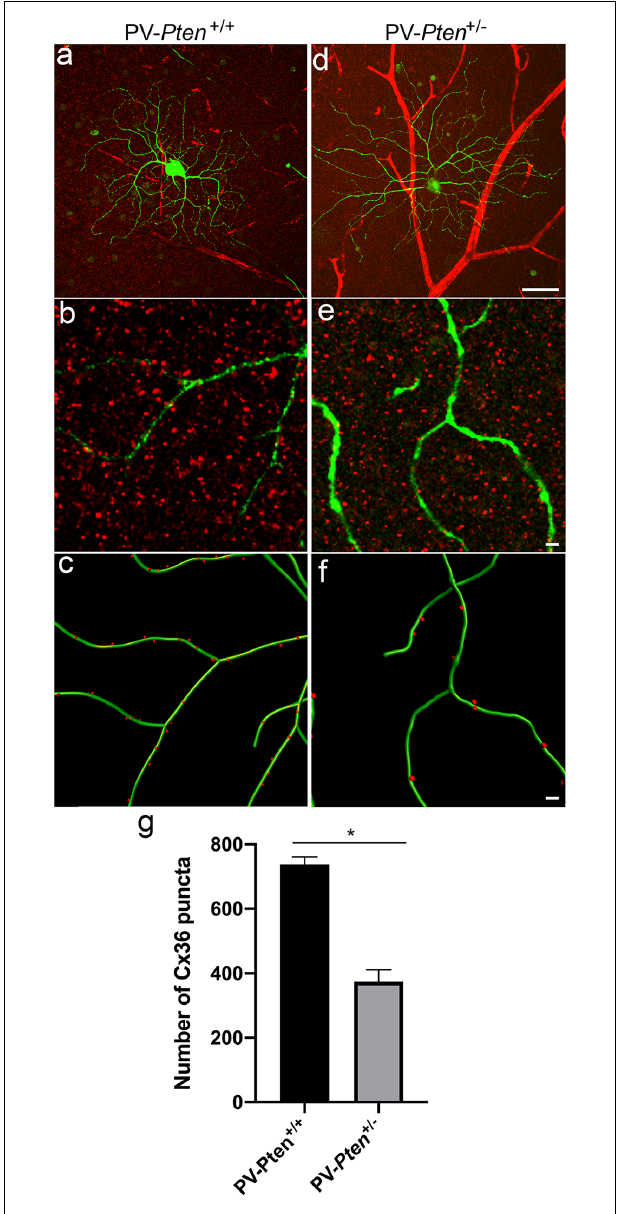
FIGURE 8 | Cx36 expression in OFF α -RGCs in PV- Pten +/+ and PV- Pten +/- retinas. (A) A maximum projection of a Neurobiotin-filled OFF α -RGC (green) stained with Cx36 antibodies (red) in a PV- Pten +/+ retina at 1.0 mm from the optic nerve head. (B) A single optical section of the Neurobiotin-filled OFF α -RGC (green) stained with Cx36 antibodies (red) in PV- Pten +/+ retina. (C) Imaris reconstruction of panel (B) . Cx36 puncta closer than 0.3 µ m to the dendrites are represented in red. (D) A maximum projection of a Neurobiotin-filled OFF α -RGC (green) stained with Cx36 antibodies (red) in PV- Pten +/- retina at 1.0 mm from the optic nerve head. (E) A single optical section of the Neurobiotin-filled OFF α -RGC (green) stained with Cx36 antibodies (red) in PV- Pten +/- retina. (F) Imaris reconstruction of panel (E) . Cx36 puncta closer than 0.3 µ m to the dendrites are represented in red. (G) Histogram indicating the mean ( ± SEM) of Cx36 puncta in OFF α -RGCs ( n = 3 cells from PV- Pten +/+ retinas, n = 5 cells from PV- Pten +/- retinas, * P < 0.05, Mann-Whitney test). Scale bar in (A,D) = 50 µ m. Scale bar in (B,C,E,F) = 2 µ m.